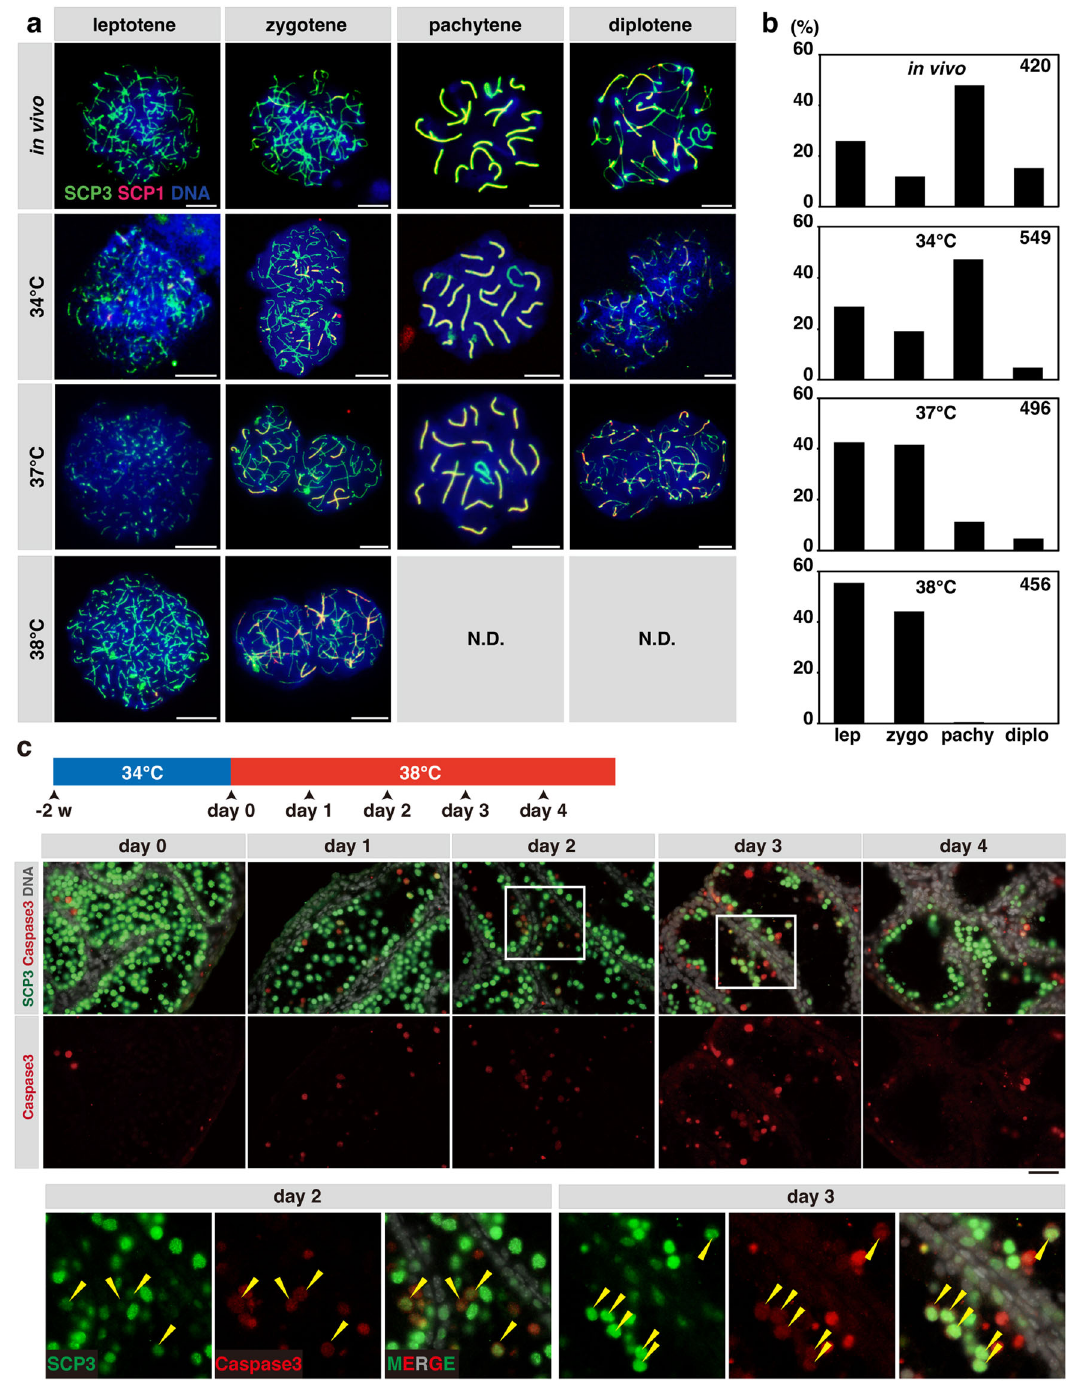
Fig. 3 Meiotic prophase I progression and apoptosis in spermatocytes in ex vivo culture at different temperatures. a Representative images of chromosomal spreads at different stages of meiotic prophase I, prepared from in vivo-developed testes of 5-week-old Acr-GFP mice and from testis explants cultured at 34, 37, or 38 °C for 5 weeks as indicated. Samples were stained for SCP3, SCP1, and DNA (Hoechst 33342). Scale bars, 10 μ m. b Proportions of spermatocytes in the leptotene (lep), zygotene (zygo), pachytene (pachy), and diplotene (diplo) stages, found in explants cultured for 5 weeks at the indicated temperatures classi fi ed visually on the chromosome spreads after immuno fl uorescence-staining for SCP1 and SCP3 as ( a ), according to the criteria described in the text. Values obtained from chromosome spreads prepared from pooled testicular cells of two in vivo-developed testes from different individuals and those from 6 to 7 ex vivo-grown explants are summarized. The total number of spermatocyte nuclei counted is indicated at the upper right of each panel. Percentages of spermatocytes nuclei in which all the autosomes have completed synapsis (i.e., the sum of pachytene and diplotene spermatocytes) were 63, 52, 16, and 0.5% for in vivo and ex vivo samples at 34, 37, and 38 °C, respectively. c Detection of cleaved Caspase-3 (red) and SCP3 (green) in testis explants following the temperature shift from 34 to 38 °C. Double-stained images overlaid with DNA staining (gray) and the signals for cleaved Caspase-3 alone are shown in the upper and lower panels, respectively. Enlarged images at positions indicated by rectangles are also shown below. Yellow arrowheads, Caspase-3 + /SCP3 + double-positive cells (the dying spermatocytes). Scale bars, 40 μ